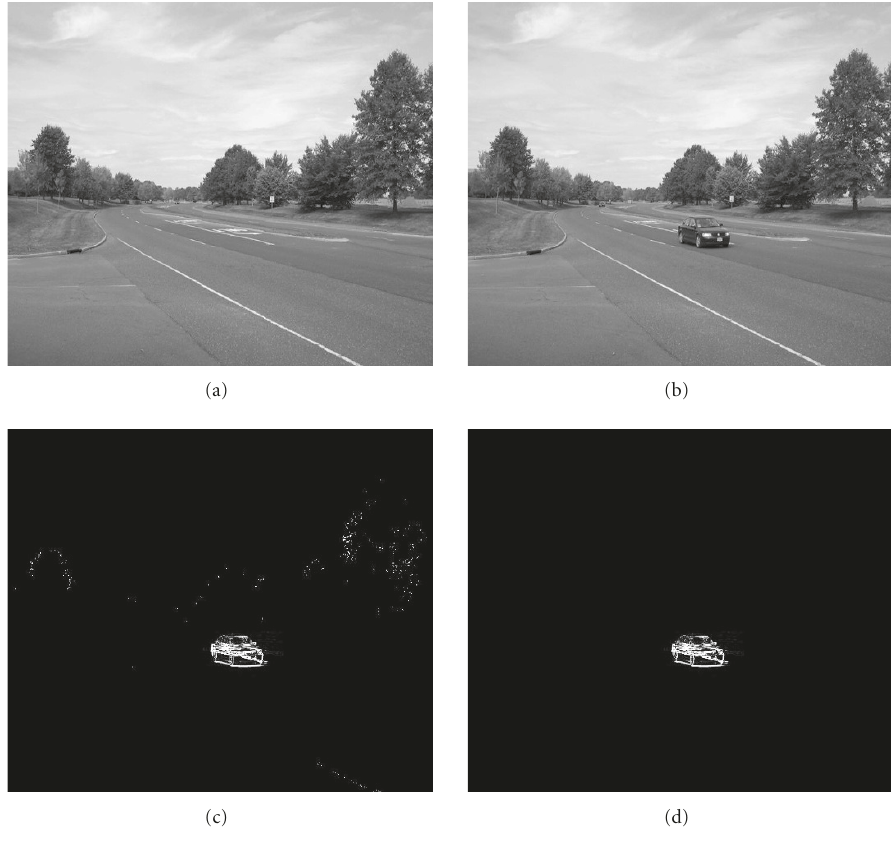
Figure 6: Result of background